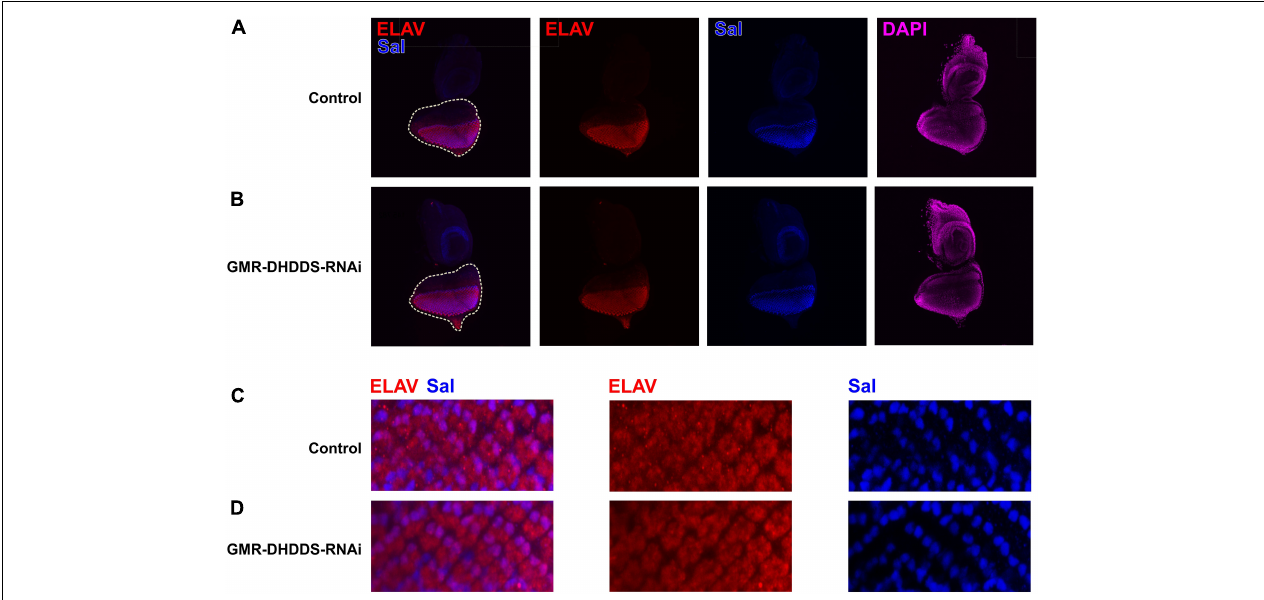
FIGURE 5 | Immunostaining of the GMR-DHDDS-RNAi imaginal eye discs. Eye discs of GMR-DHDDS-RNAi and control (GMR/GFP) late third instar larvae were collected and stained with DAPI (nuclei, magenta), ELAV (developing photoreceptors, red), and Sal (R3/R4 differentiation and planar polarity, blue). (A,B) × 20 magnification of control GMR/GFP (A) and GMR-DHDDS-RNAi (B) imaginal eye discs. (C,D) × 40 magnification of sections of control (C) and GMR-DHDDS-RNAi (D) imaginal eye discs. The sections were selected to include Sal expression at R3/R4. Note that ELAV and Sal are normally expressed in the GMR-DHDDS-RNAi and control